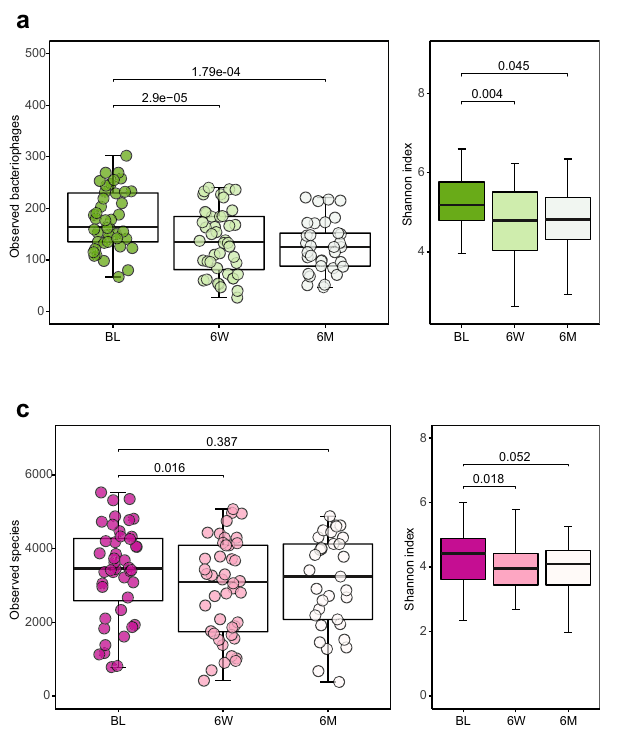
Fig. 4 | Biodiversity alteration of bacteriophages and bacteria after H. pylori eradicationtherapy.a Signi fi cantlyalteredbacteriophagealphadiversityinphage richness and Shannon index after eradication therapy (Wilcoxon tests followed by BH correction) between three groups (BL: N =44; 6W: N =44; 6M: N =33; N , the number of patients included in each group). b Difference in bacteriophage com- munity (beta-diversity) presented in PCoA plot based on phage community dis- similarity distance at the phage species level (PERMANOVA tests followed by BH correction) between three groups (BL: N =44; 6W: N =44; 6M: N =33). Compar- isonsofdistanceofbacteriophagesaftereradicationtherapy. c Signi fi cantlyaltered bacteriaalphadiversityinbacteriarichnessand Shannonindexafterthe treatment